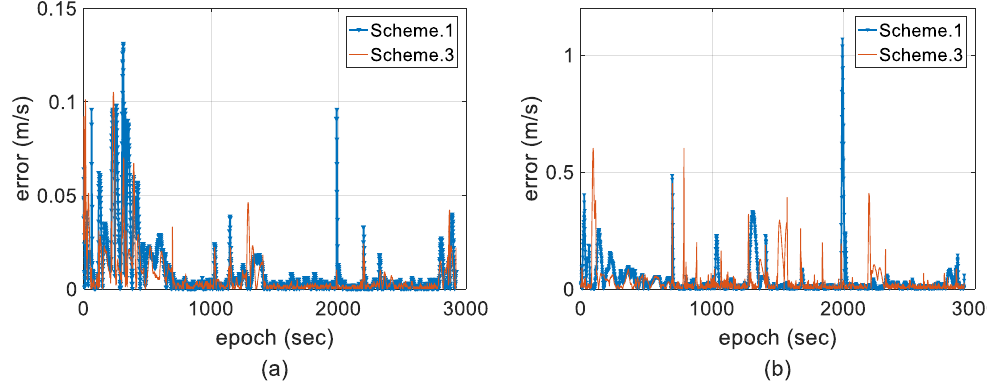
Figure 12. Comparisons of velocity error. ( a ) Horizontal; and ( b ) vertical.